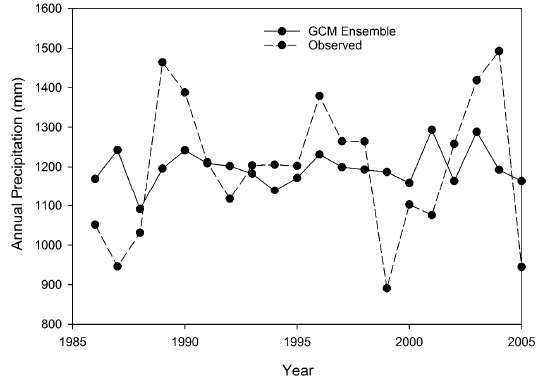
Figure 3. GCM ensemble and observed annual precipitation for the time frame of 1986–2005.